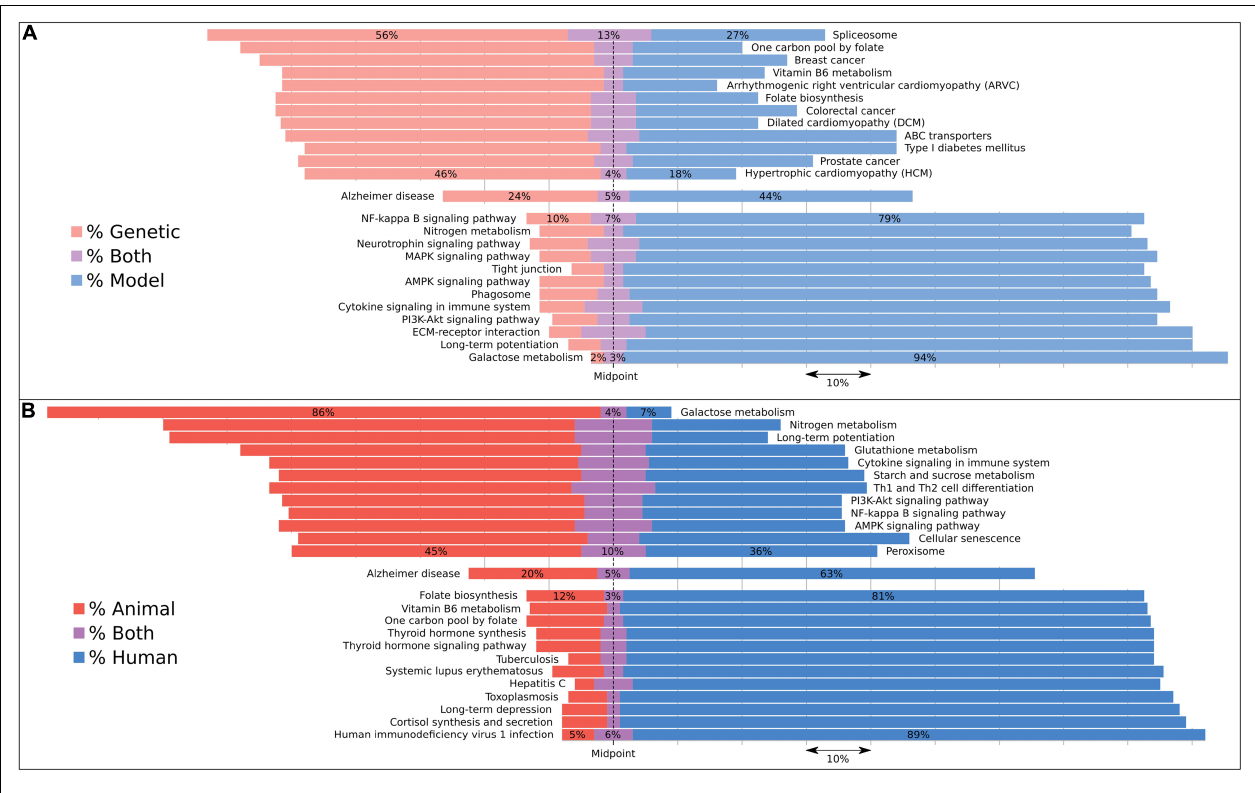
FIGURE 3 | Pathways associated with AD subcategorized by evidence type using dictionaries to reveal biases in their associations. Bars are aligned along the midpoint of the neutral grouping, so that a direct comparison can be made of the two competing groups. The missing percentage from this chart is for studies assigned to neither evidence category, but this value can be inferred by subtracting the total bar quantity from 100, or found in Supplementary Table 5 . We compared (A) genetic with model studies and (B) animal with human studies. We included the 12 most skewed pathways for each of these four evidence types as well as the Alzheimer’s disease pathway, which represents the AD expected rate for each category. Both human and animal studies were included under the model category. Pathways with less than 100 studies associating them to dementia were